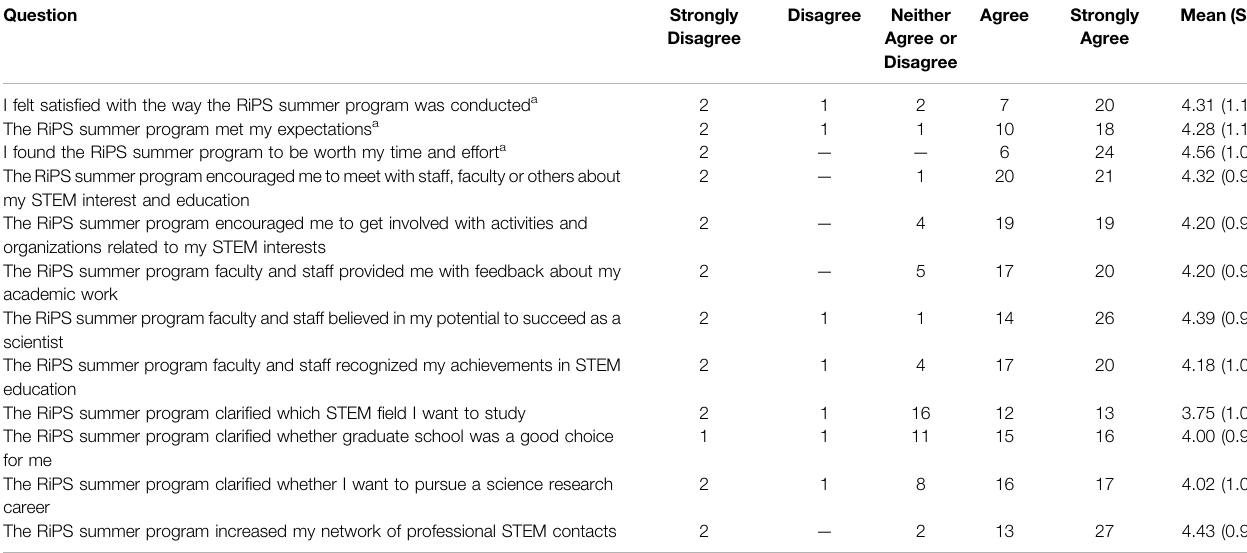
TABLE 2 | Overall program experience N (cid:1) 44. Question Strongly